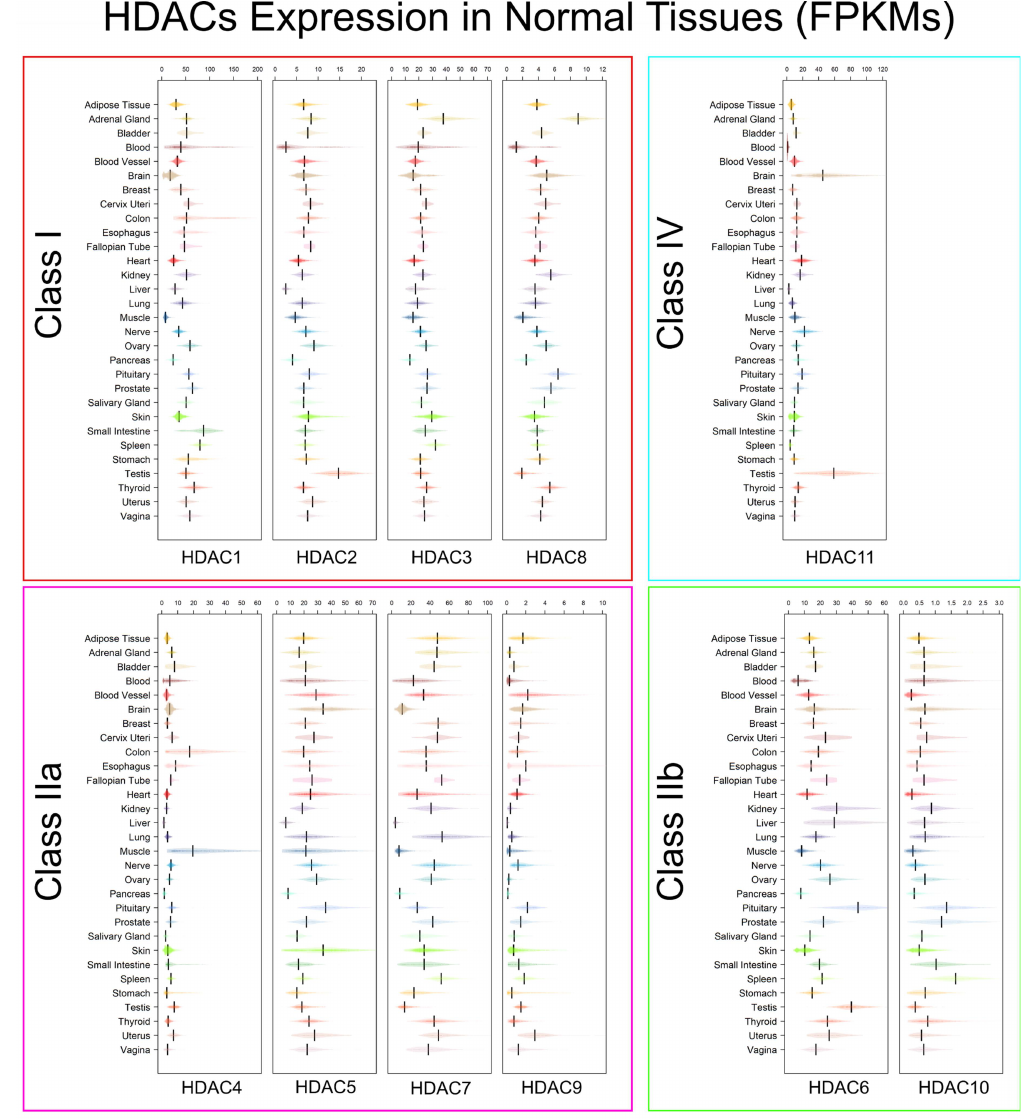
Figure 4. Transcript levels of HDACs 1–11 in healthy tissues expressed in FPKM (fragments per kilobase of transcript length per million of mapped reads). Boxplots show the expression of Class I (red box), Class IIa (pink box), Class IIb (green box), and Class IV (aquamarine box) from normal samples in the GTEx Release V8 dataset. Expression was FPKM-normalized using the length of ENSEMBL longest isoform and RNA-Seq data from GTEx